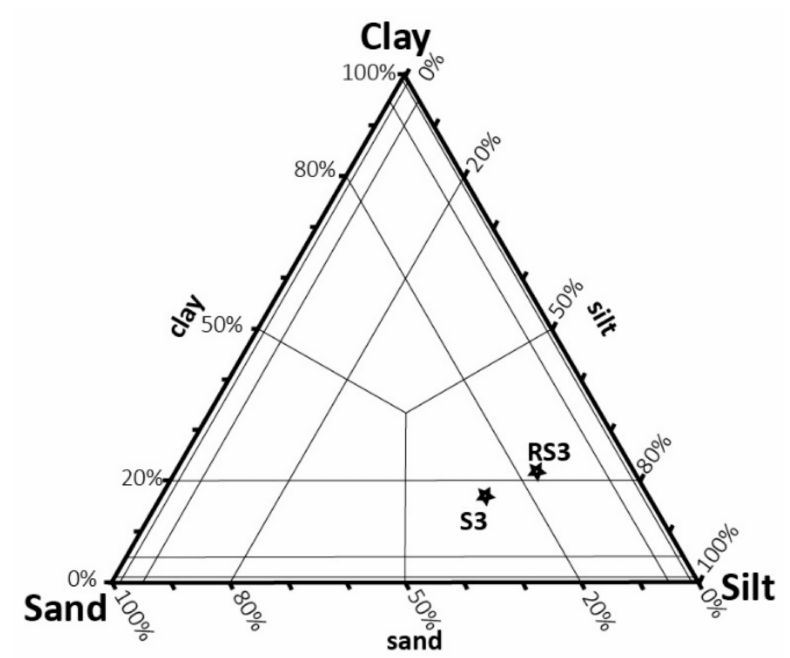
Figure 3. Grain-size distribution data for sample S3 and